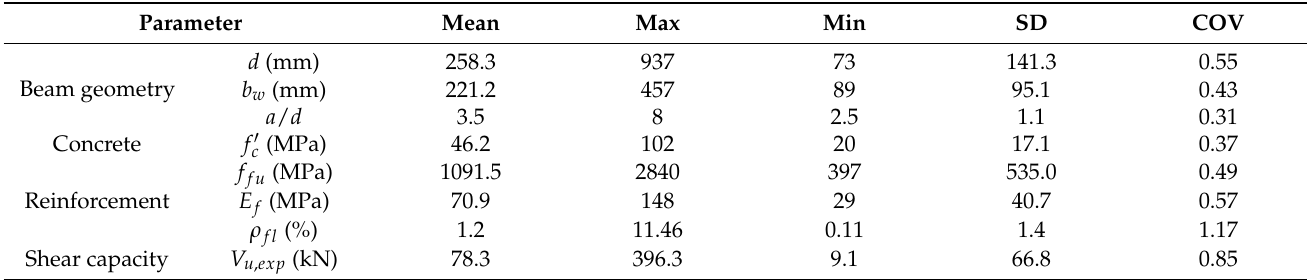
Table 2. Statistics of